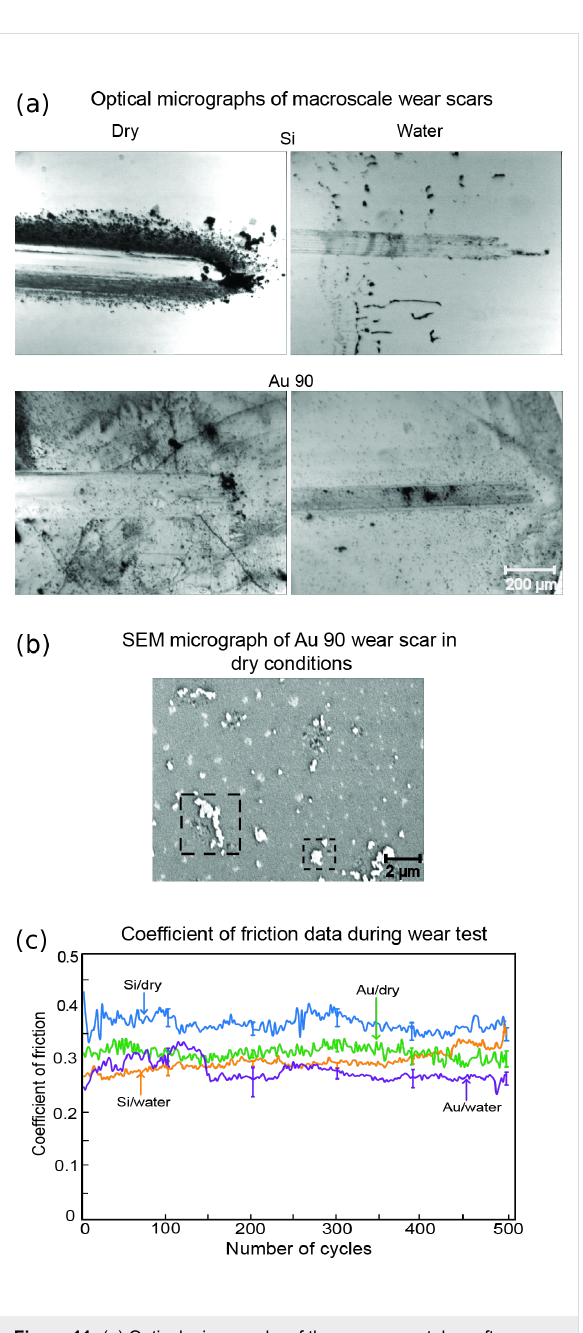
Figure 11: (a) Optical micrographs of the wear scars taken after 500 cycles. (b) SEM micrograph of the wear scar for agglomerated Au 90 nanoparticles, within the squares, under dry conditions. (c) Coefficients of friction from ball-on-flat tests, for both dry and water conditions, with and without Au 90